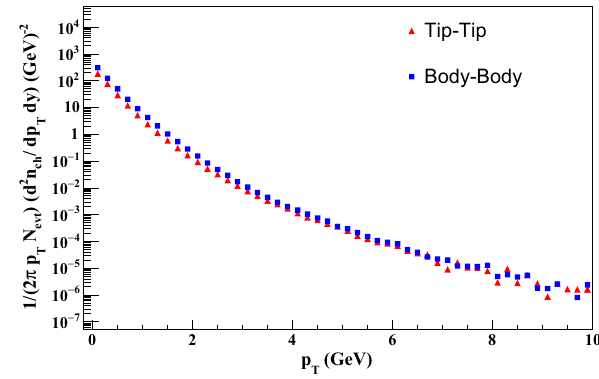
Fig. 19 Comparison of transverse momentum distribution of charged hadrons in tip–tip and body–body configuration for most peripheral collision